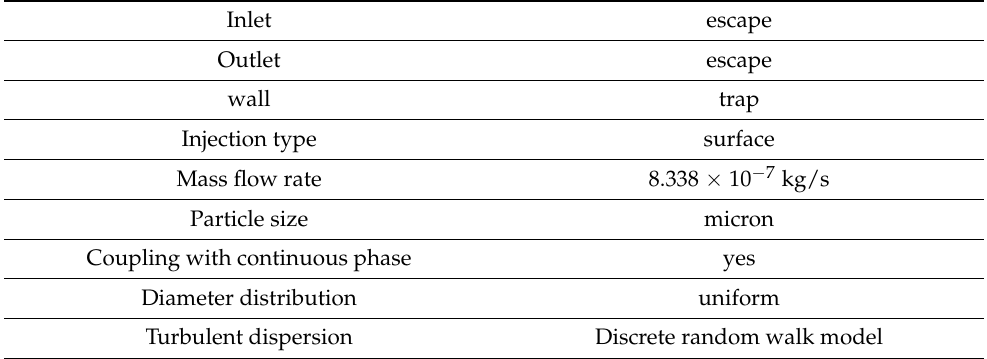
Table 3. Discrete phase model boundary conditions.